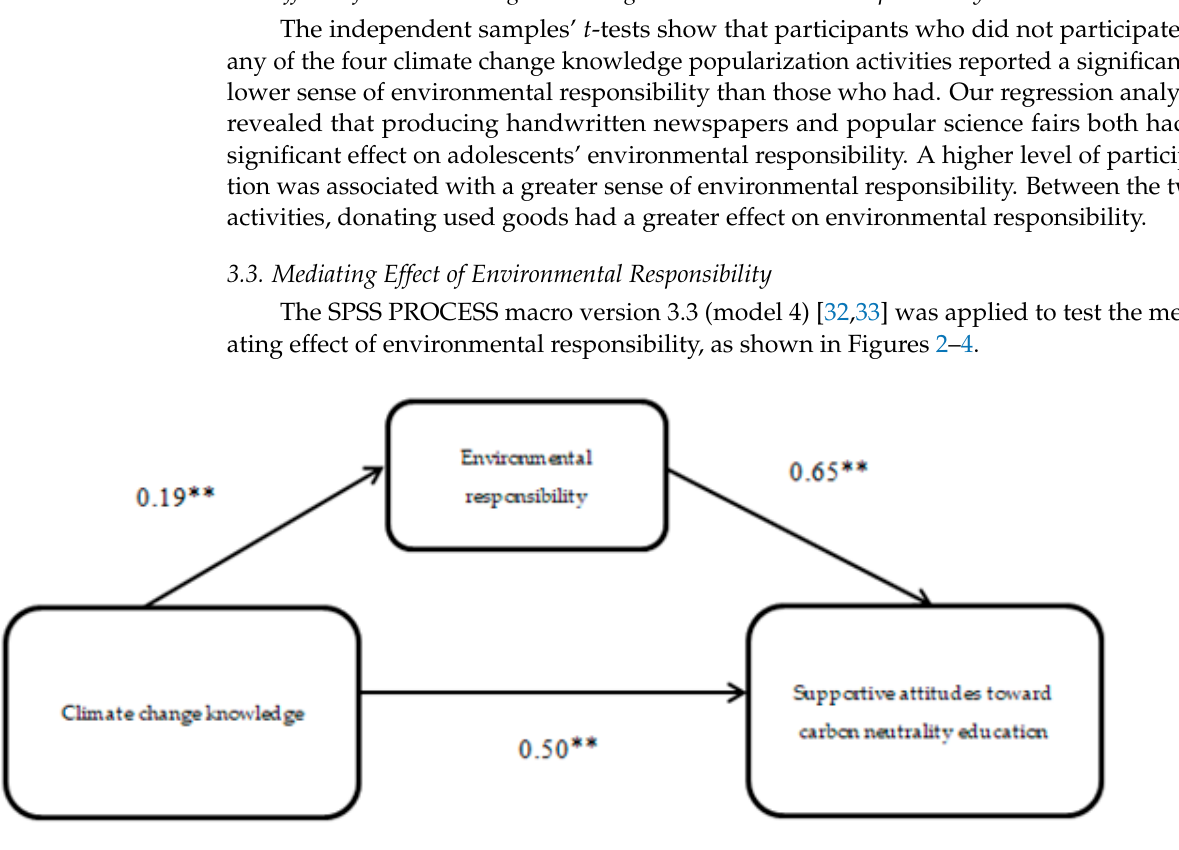
Figure 3. Model of willingness to participate in carbon neutrality courses. Note: ** p < 0.01. Figure 4. Model of preferred hours of carbon neutrality education. Note: ** p < 0.01.